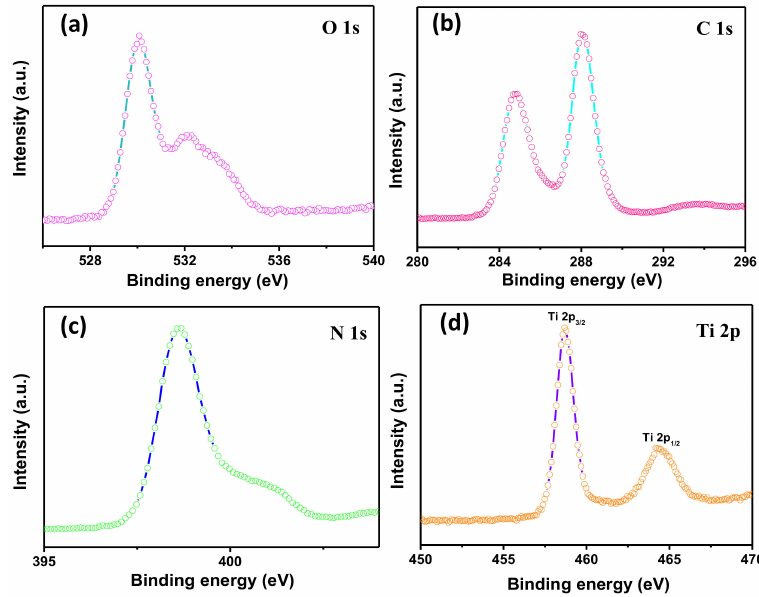
Figure 4. XPS spectra of CNT6: ( a ) O 1s region; ( b ) C 1s region; ( c ) N 1s region and ( d ) Ti 2p